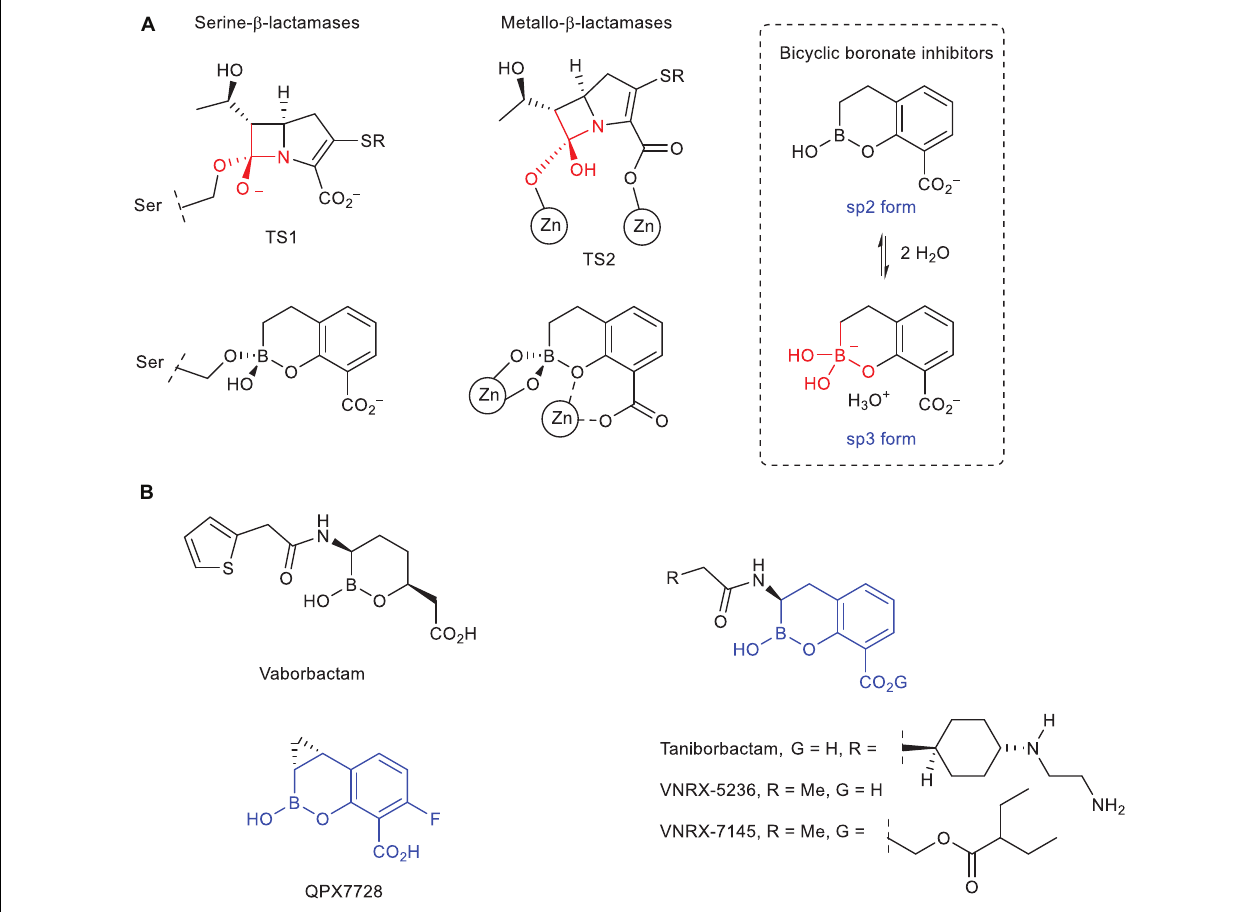
FIGURE 1 | (A) Schematic representation of the transition state analogs in the carbapenem hydrolysis catalyzed by serine- and metallo- β -lactamase enzymes and the resulting bicyclic boronate adduct and di-Zn(II) enzyme complexes. The sp2/sp3 equilibrium forms of the bicyclic boronate inhibitors are also shown. (B) Chemical structures of vaborbactam (formerly RPX7009), taniborbactam (formerly VNRX-5133), VNRX-5236, VNRX-7145 (oral proform of VNRX-5236), and